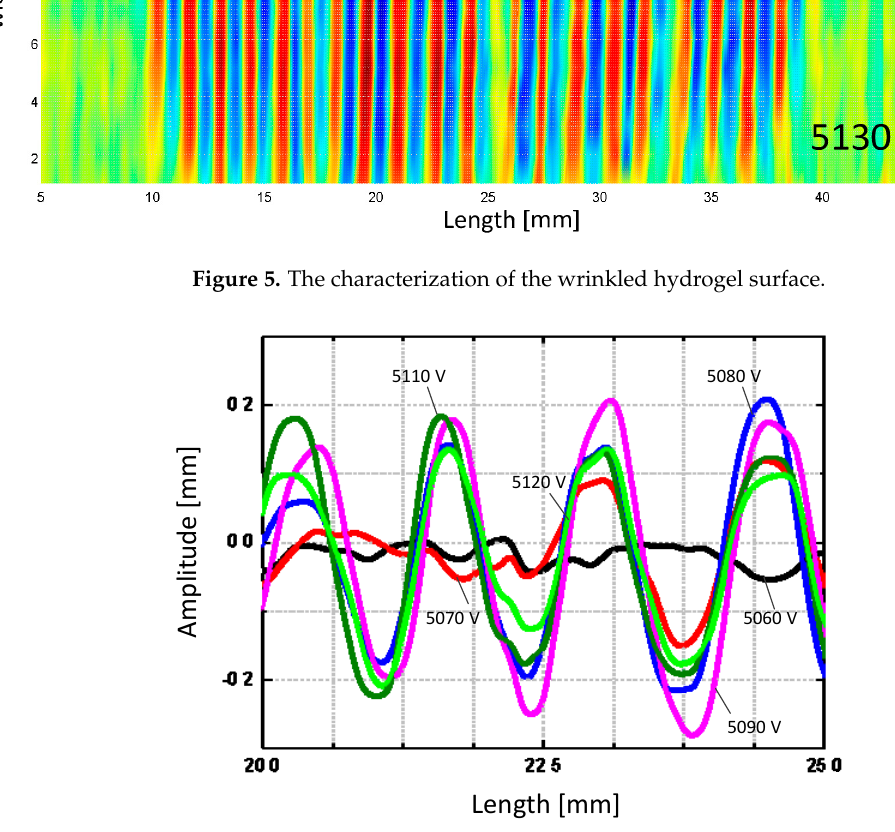
Figure 6. The relationship of wrinkle morphology as a function of the voltage.